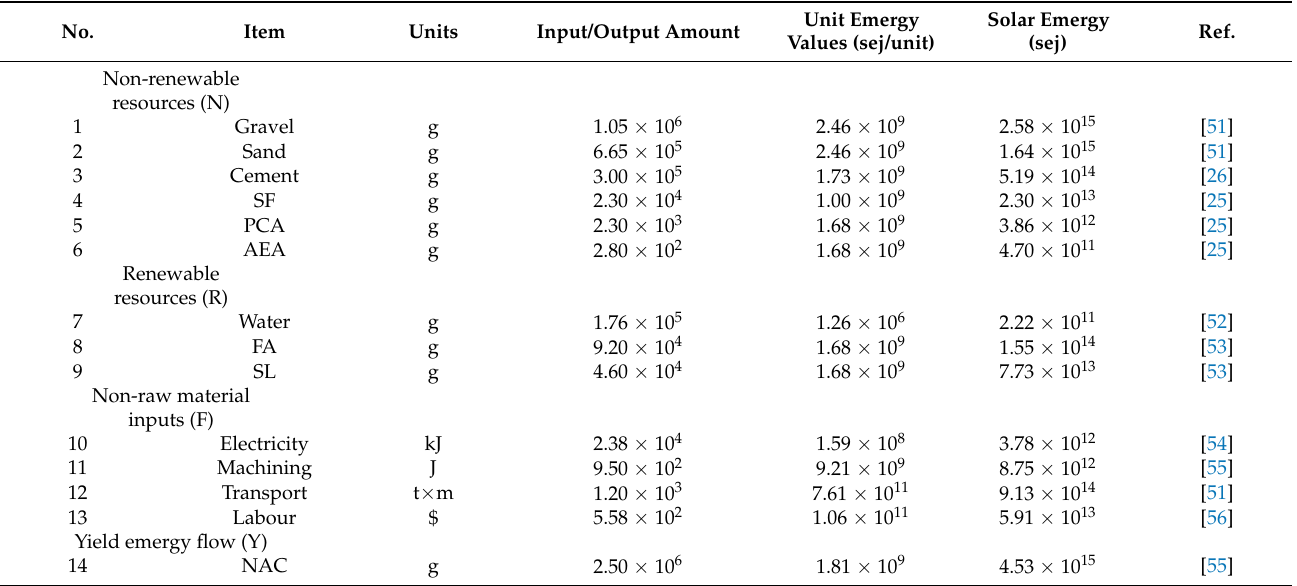
Table 5. Emergy evaluation form of NAC.